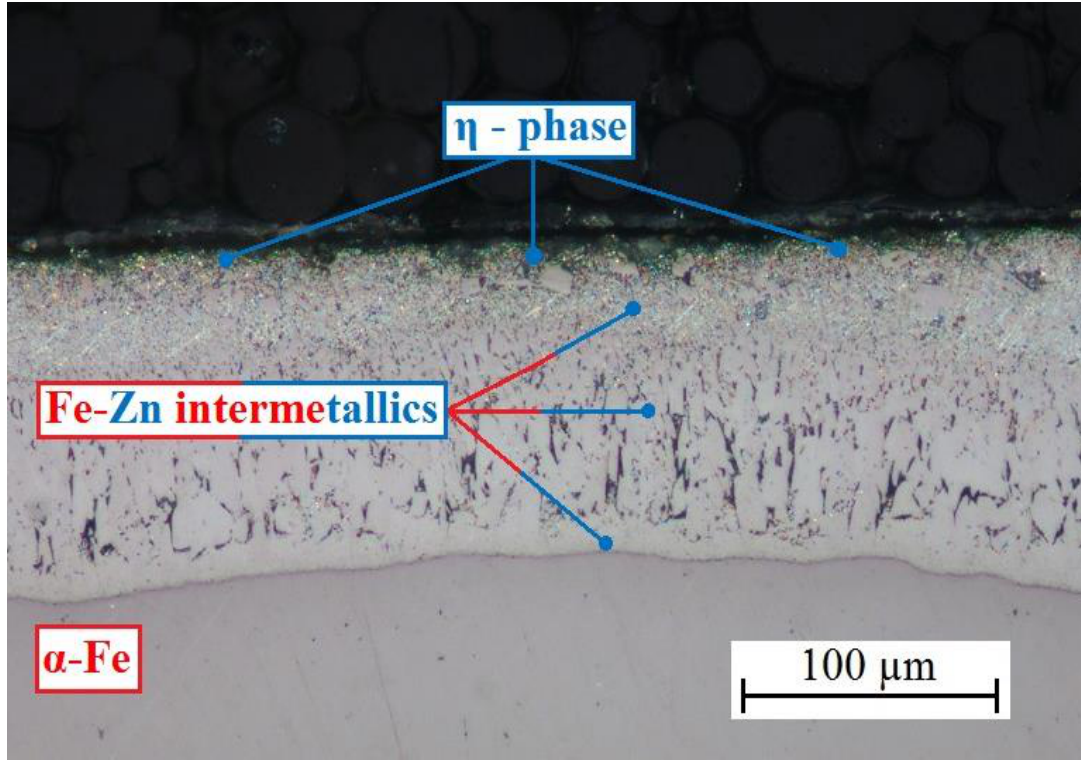
Figure 2. Cross cut of HDG zinc coating on flat steel sheets — overview.